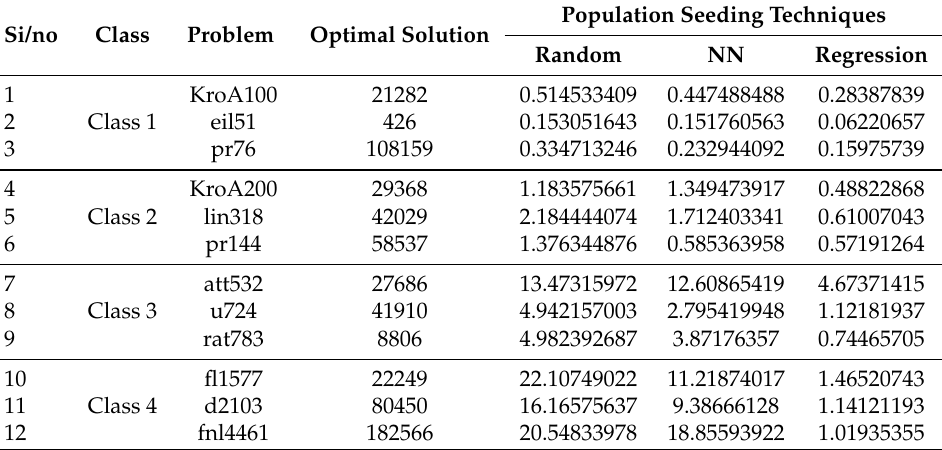
Table 13. Final solution error rate (%) results for Random, NN and our Regression techniques.